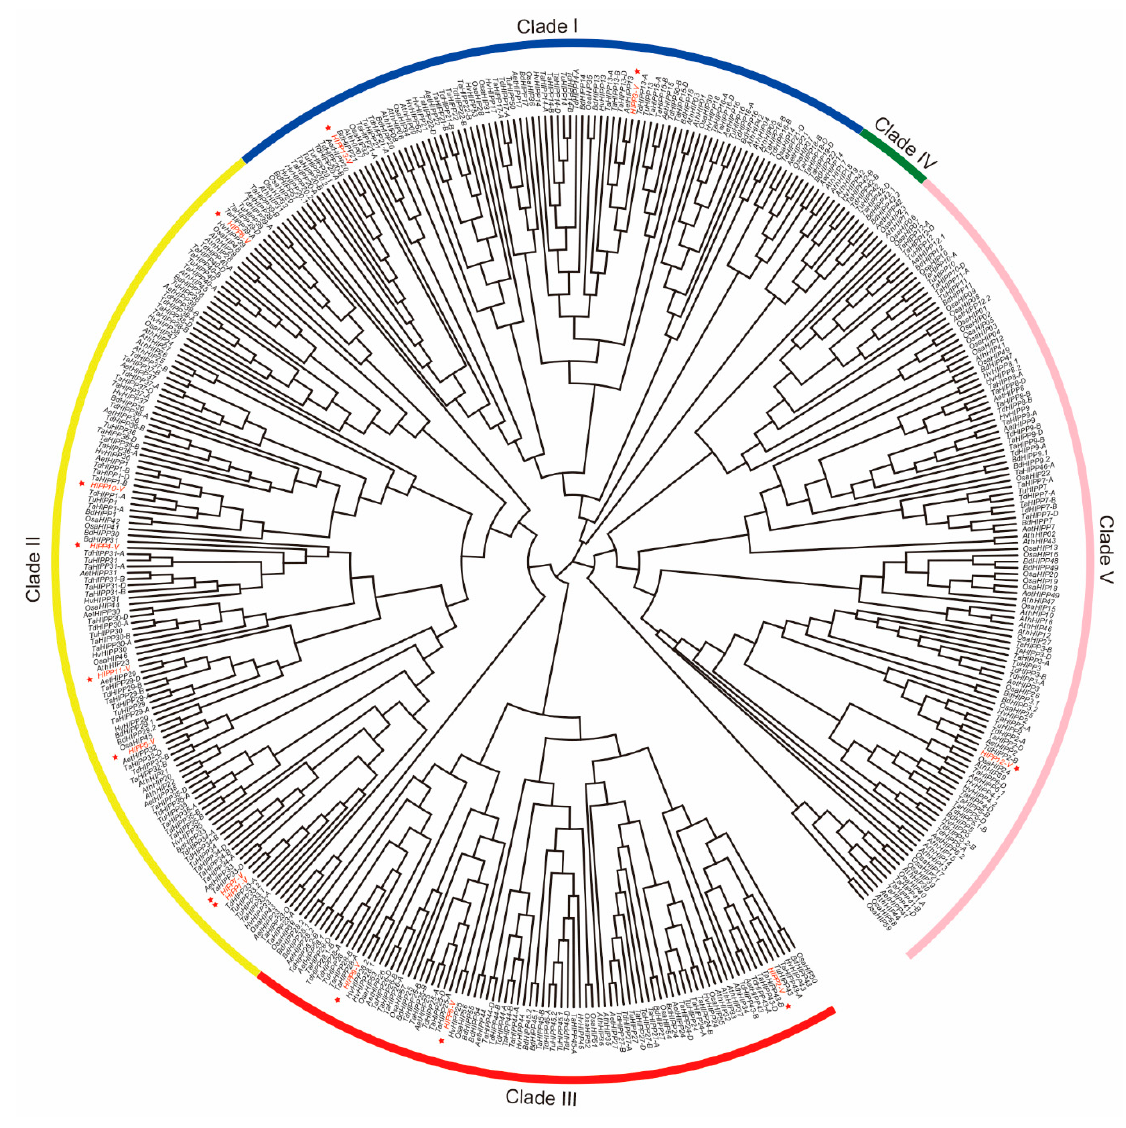
Figure 2. The phylogenetic analysis of the HIPP gene family from nine plant species. Species